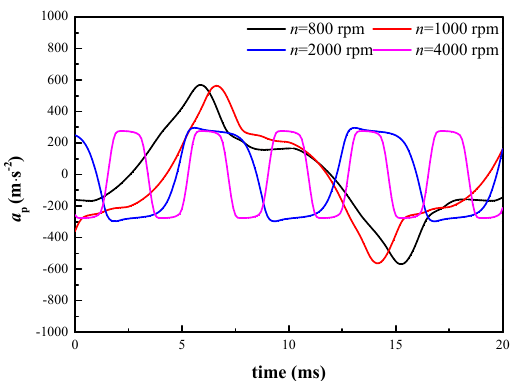
Figure 12. Accelerations of different valve spool rotation speeds when the supply pressure is 4 MPa.